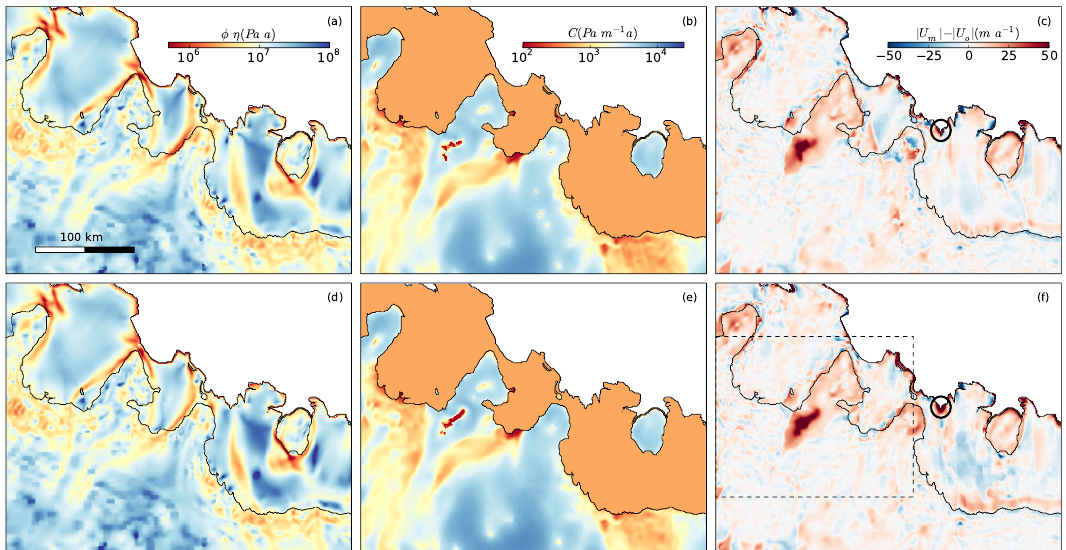
Figure 4. Results of the control method for B/S and B/U (a–c) and RF/S (d–f) initialisations, for linear sliding. Vertically averaged effective viscosity (a, d) , basal friction coefficient (b, e) (for current ice shelves, the value of C = 500Pam − 1 a is prescribed for transient simulations) and difference between modelled and observed velocities (c, f) . The circles indicate PPw (c, f) . The dashed box (f) marks the large mismatches that are discussed in the text and shown in more detail in Fig. S1 in the